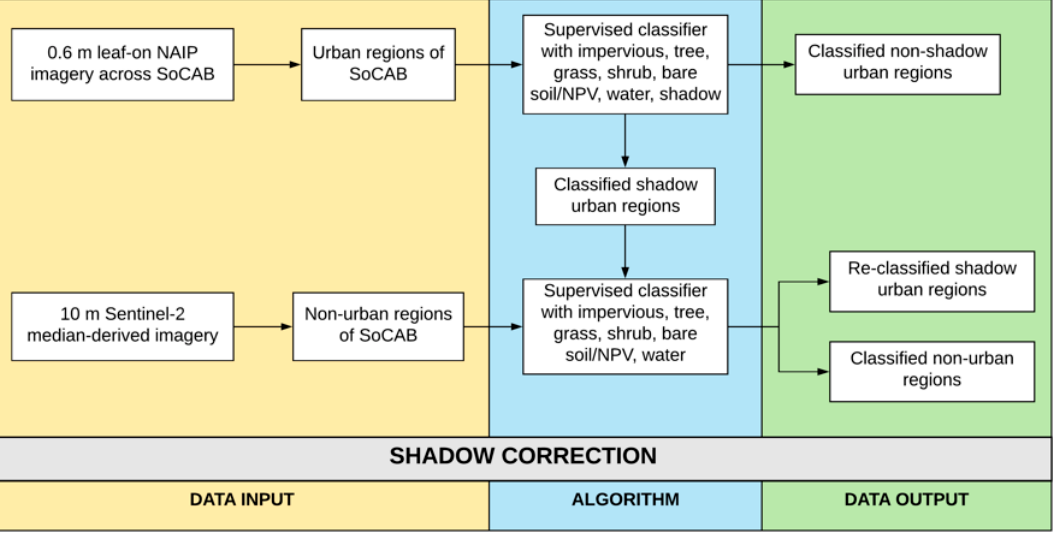
Figure 3. Combining classified Sentinel-2 and NAIP imagery into a single data product across SoCAB enabled classification in shadow and mountainous regions, while maintaining a high spatial resolution in other urban regions.